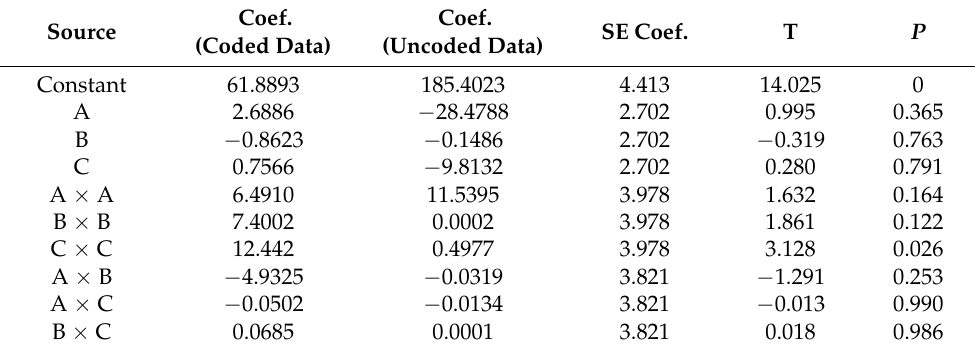
Table 6. ANOVA table of water vapor permeability index of the treated fabric for the different parameters (S = 7.643; R 2 = 77.2%).